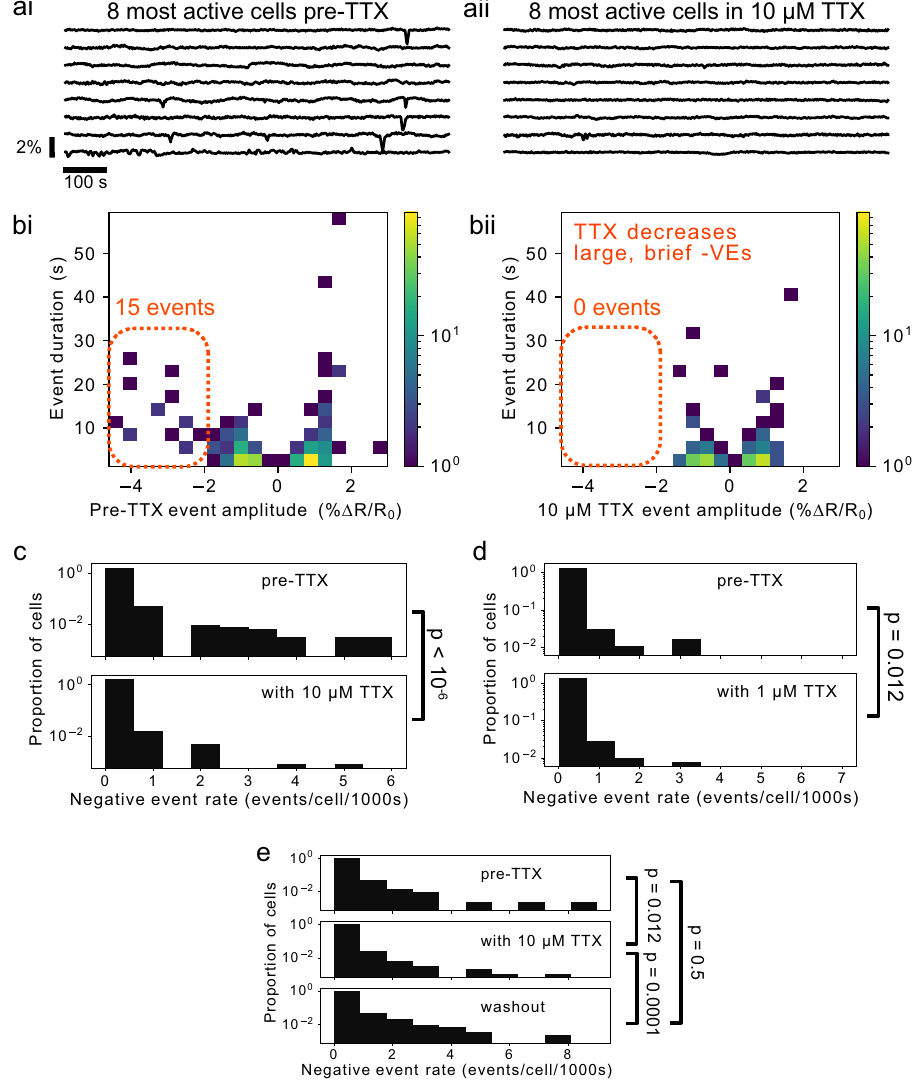
Fig. 6 TTX decreased V m fl uctuations in MDA-MB-231 cells. ai , ii Example V m time courses from the 8 most active cells in acquisitions before ( ai ) and with ( aii ) 10 μ M TTX. bi , bii Log-scaled 2D histograms of detected events before ( bi ) and with ( bii ) 10 μ M TTX. TTX eradicates virtually all large, hyperpolarizing events ( − VEs, dashed orange outline). c Log-scaled histograms of the − VE event rate per cell for pre- and post-application of 10 μ M TTX. The reduction in the mean from 9.5 × 10 − 5 events/cell/s to 1.97 × 10 − 5 events/cell/s (~4× decrease) is signi fi cant with p < 10 − 6 . d The effect of TTX is dose-dependent: 1 μ M TTX reduced the mean event rate by a lesser factor of ~2× from 1.04 × 10 − 4 events/cell/s to 4.99 × 10 − 5 events/cell/s ( p = 0.019). e The effect of TTX is reversible. The effects of TTX can be reversed by washing out the toxin, signi fi cantly increasing the − VE